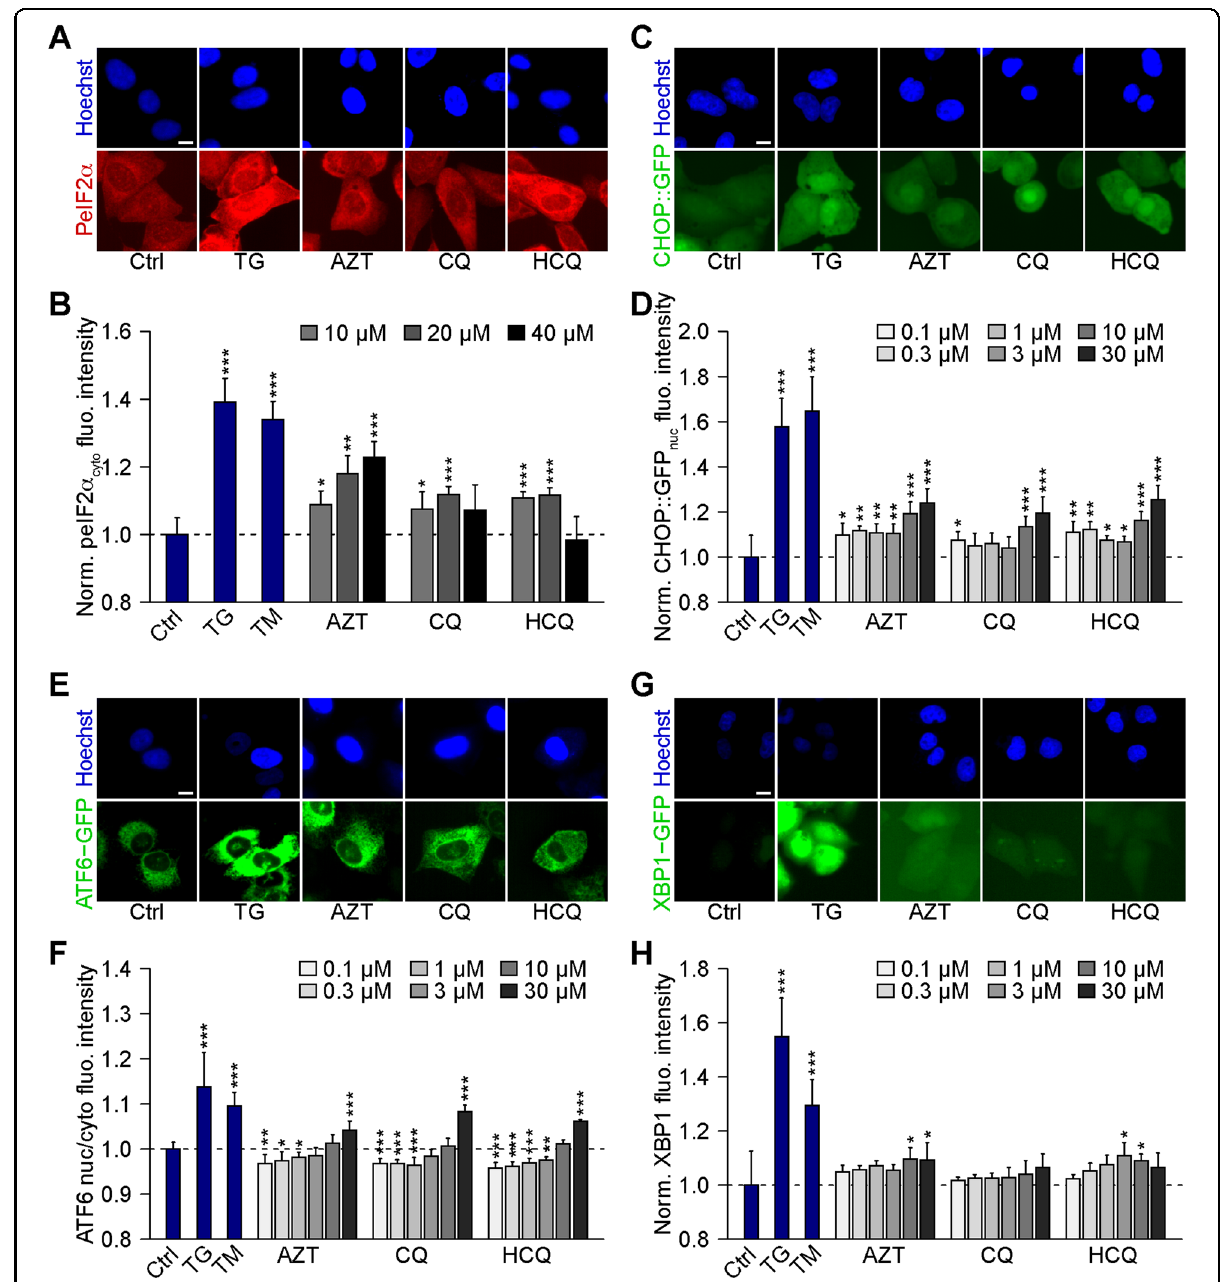
Fig. 2 Chloroquine, hydroxychloroquine, and azithromycin induce ER stress. A , B Human osteosarcoma U2OS cells were treated with chloroquine (CQ), hydroxychloroquine (HCQ), and azithromycin (AZT; all at 10, 20, 40 μ M) for 16 h, then fi xed and imaged. Tunicamycin (TM, 3 μ M) and thapsigargin (TG, 3 μ M) were used as positive controls for ER stress induction. PeIF2 α was assessed by means of an immuno fl uorescence staining using a phosphoneoepitope-speci fi c antibody ( A ) and the cytoplasmic intensity is depicted ( B ) (AZT, CQ, and HCQ, 40 µM). C , D Human osteosarcoma U2OS cells stably expressing GFP under the promoter of DDIT3 (CHOP::GFP) were treated with the indicated agents (TM (3 μ M), TG (3 μ M), CQ, HCQ, or AZT (all at 0.1, 0.3, 1, 3, 10, 30 μ M)) for 24 h. After fi xation, CHOP::GFP fl uorescence was assessed microscopically as shown in C , and the average nuclear intensity was quanti fi ed ( D ). E, F U2OS cells stably expressing GFP-ATF6 were treated with the indicated agents for 24 h. After the cells were fi xed, GFP-ATF6 nuclear translocation was assessed as shown in E (AZT, CQ, and HCQ, 30 µM), and the nuclear-to-cytoplasmic ratio of GFP-ATF6 intensity was quanti fi ed ( F ). G , H U2OS cells stably expressing XBP1 Δ DBD-venus (for monitoring venus expression upon alternative splicing of XBP1 mRNA) were treated as above for 24 h. After fi xation, XBP1s expression was assessed via fl uorescent microscopy as shown ( G ) (AZT, CQ, and HCQ, 30 µM), and the average intensity was measured ( H ). Data are means ± SD of four replicates (* P < 0.05, ** P < 0.01, *** P < 0.001 vs. vehicle control (Ctrl), Student ’ s t -test). Scale bars equal 10 μ m.